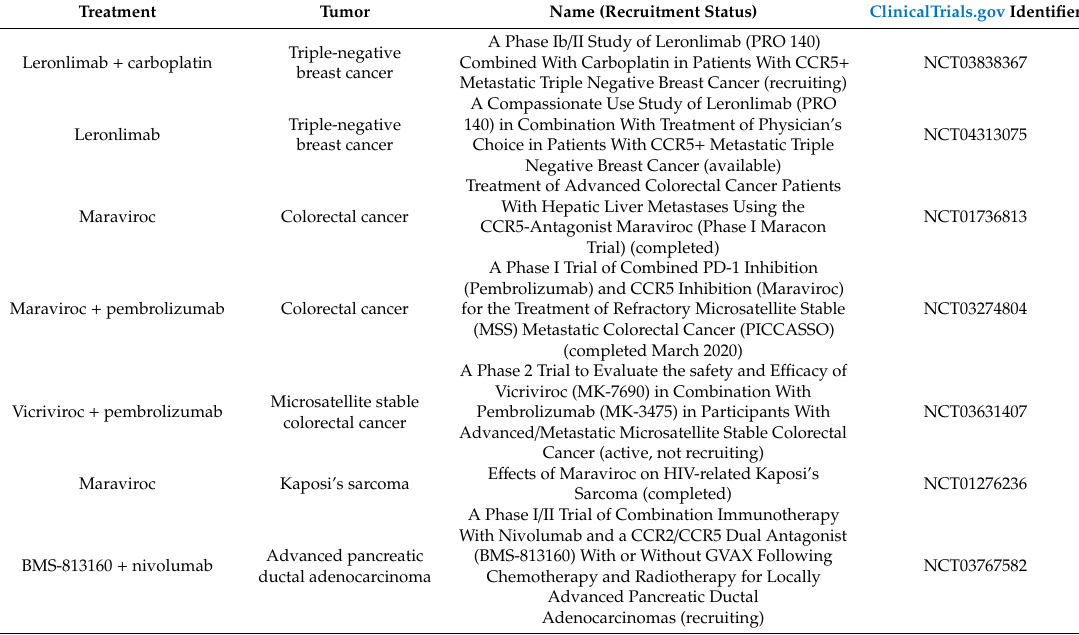
Table 3. Clinical trials with CCR5